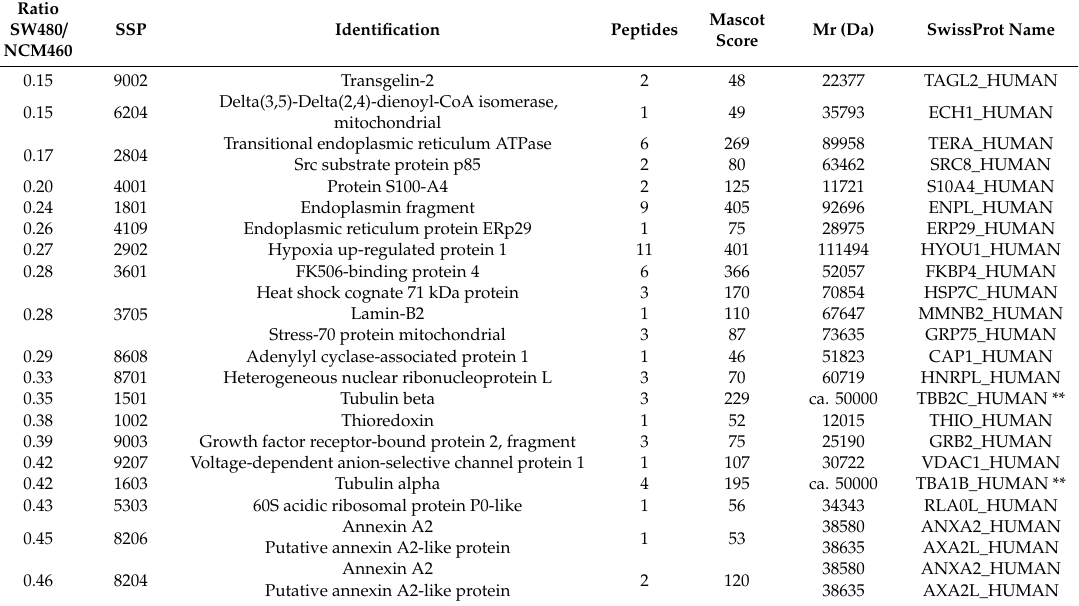
Table 2. Identification of di ff erentially expressed proteins in SW480 versus NCM460